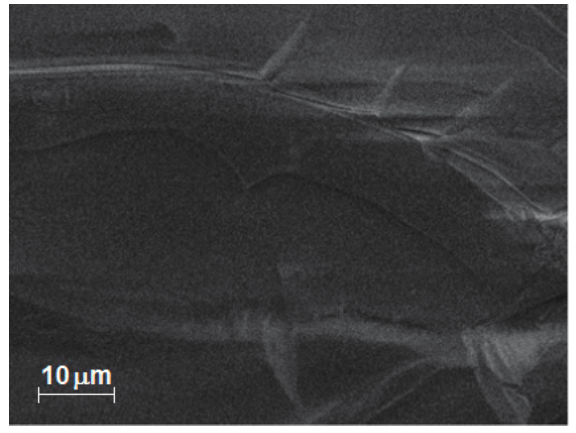
Figure 11. SEM image of a ZrO 2 xerogel with CoT( p- COOH)PP species trapped inside the pores and thermally treated at 125